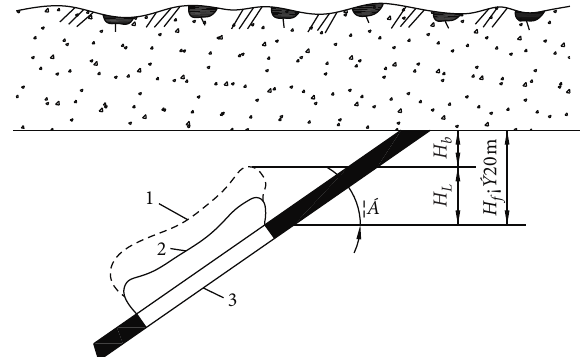
Figure 2: Expansion height of water-conducting fracture zone in simultaneous mining of all coal seams.